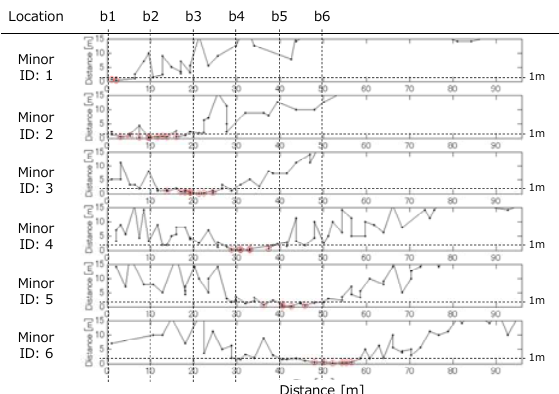
graph indicates signal receiving time. Bold points indicate RSS values more than the TxPower.